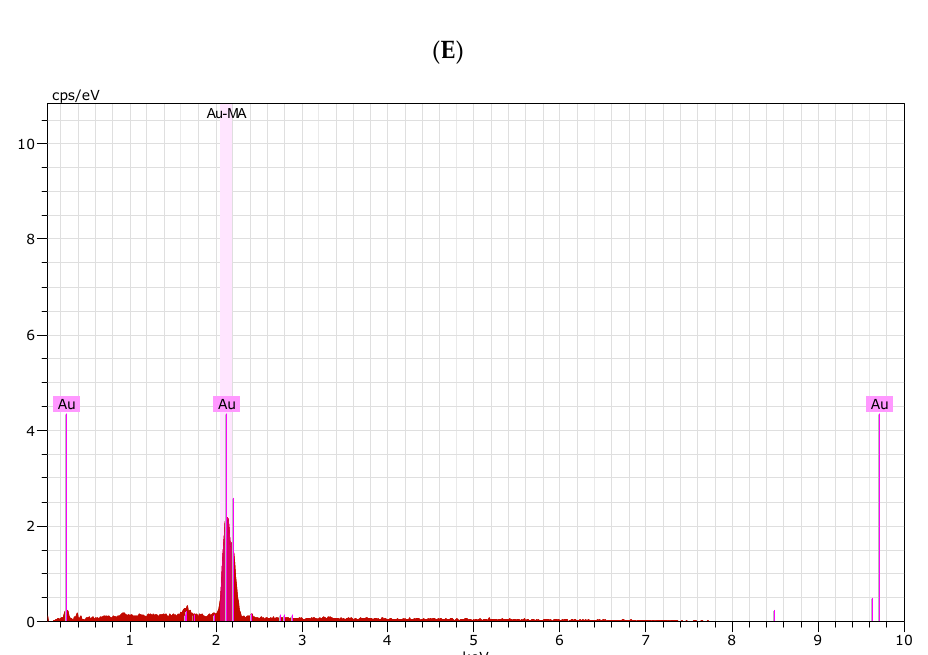
Figure 1. SEM images of bare gold SPE ( A ); Au/SWCNTs gold SPE electrode ( B ) and h-nPG gold SPE electrode ( C ); SEM image of the h-nPG gold SPE electrode with EDX analysis area ( D ); SEM-EDX spectrum of the h-nPG gold SPE electrode ( E ). Magnification: 2500 × ( A ), 50,000 × ( B ), 2500 × ( C ), 8785 × ( D ); voltage: 10 kV.